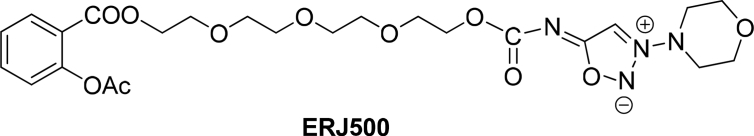
Structure of ERJ-500.